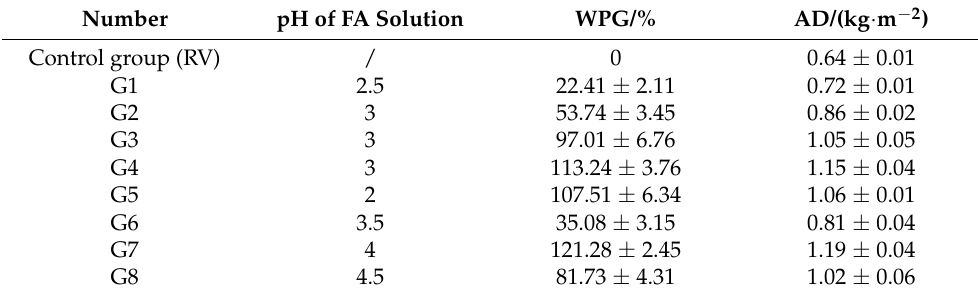
Table 2. The WPG and AD of unmodified veneer and FA-modified